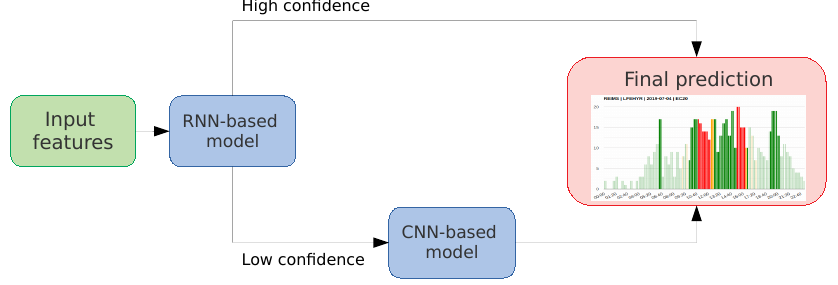
Figure 1. Simplified visual representation of developed model based on a cascade architecture. If the RNN-based model is confident, its prediction is used as the final result. If it is not confident, the CNN-based model is used to refine the